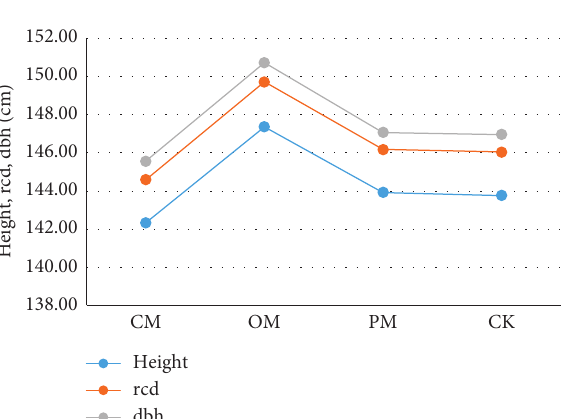
Figure 4: Root diameter, lateral root length, and main root depth.